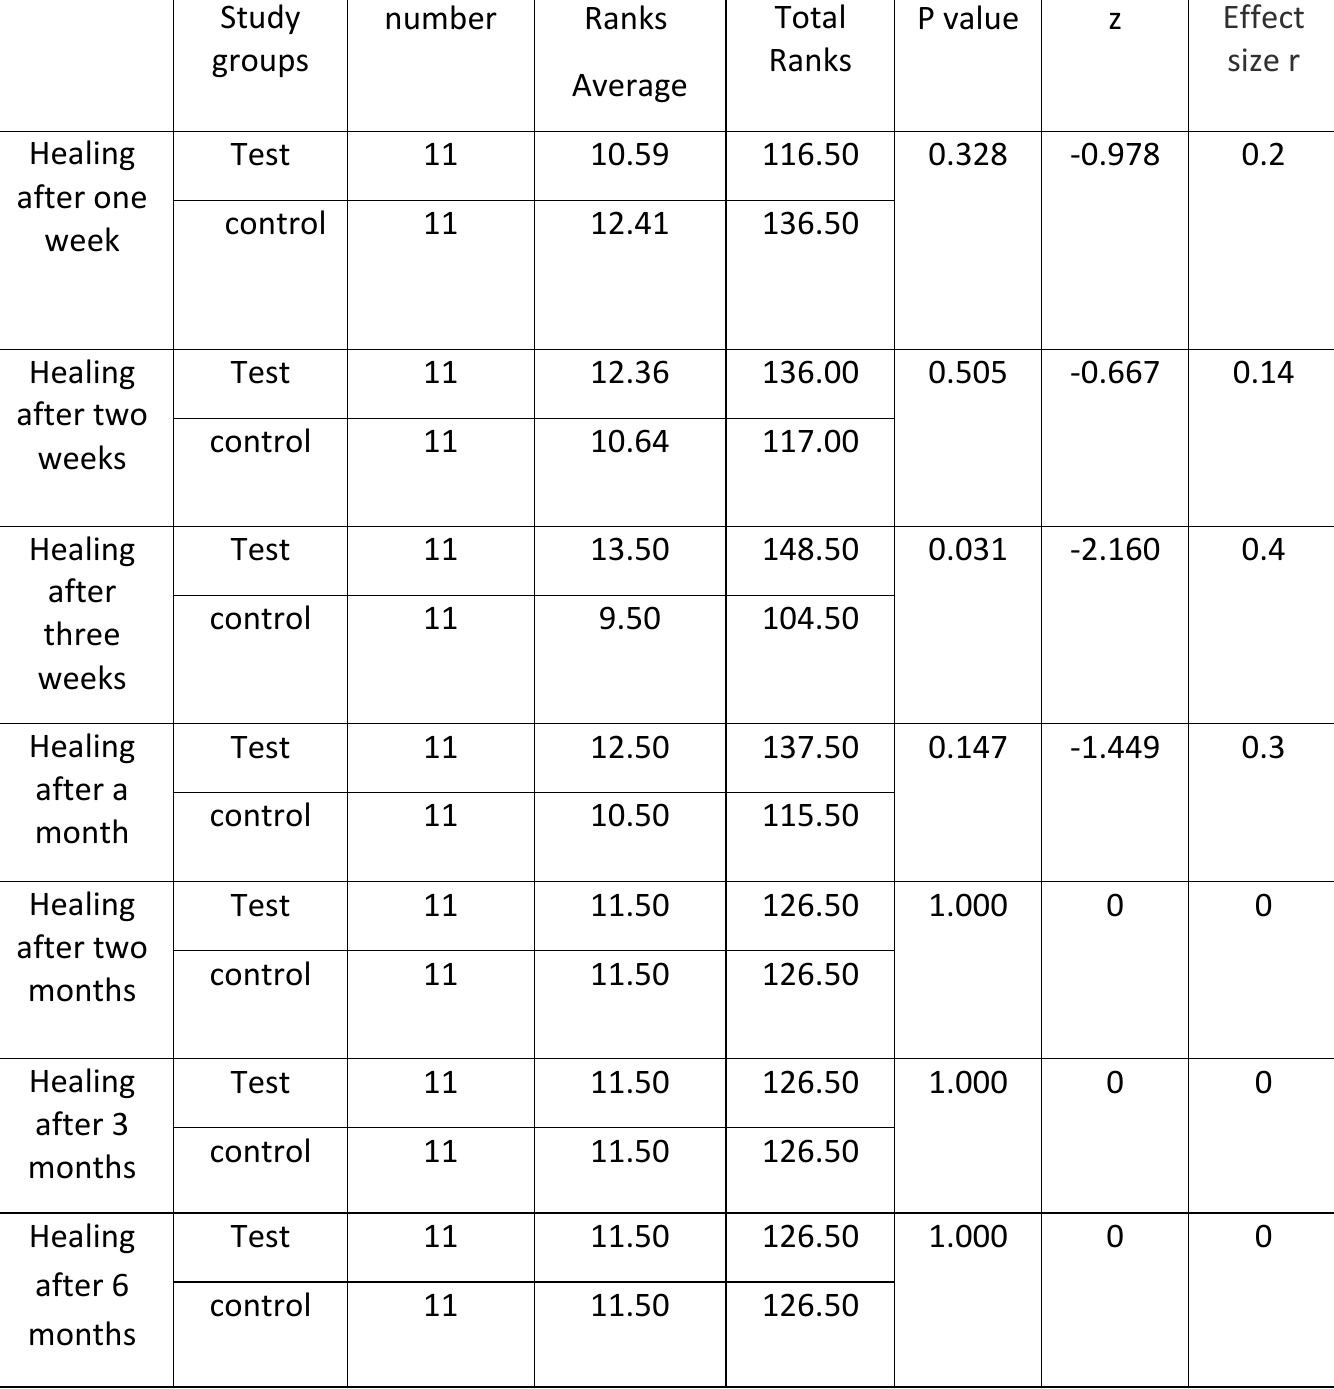
Table 2: Healing index in the receiving